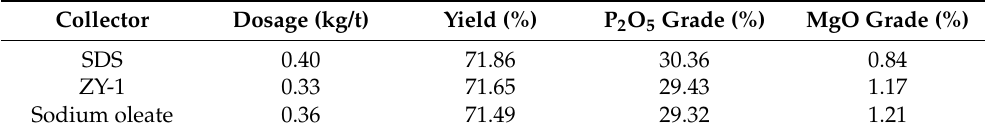
Table 5. Concentrate indexes of reverse flotation tests.